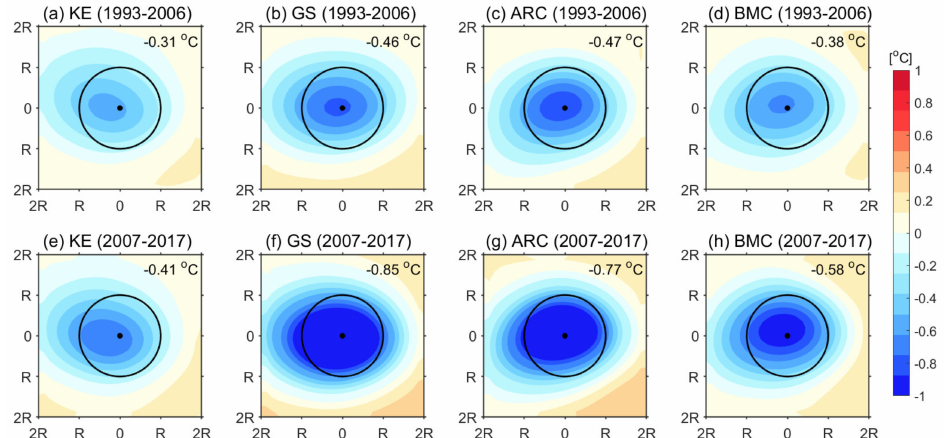
Figure 9. The same as Figure 8, except for the Cyclonic Eddy (CE)-induced SSTA.